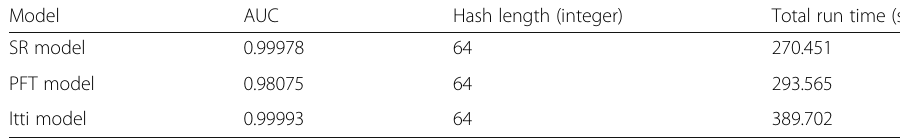
Table 5 Performance comparisons among different visual attention models Model